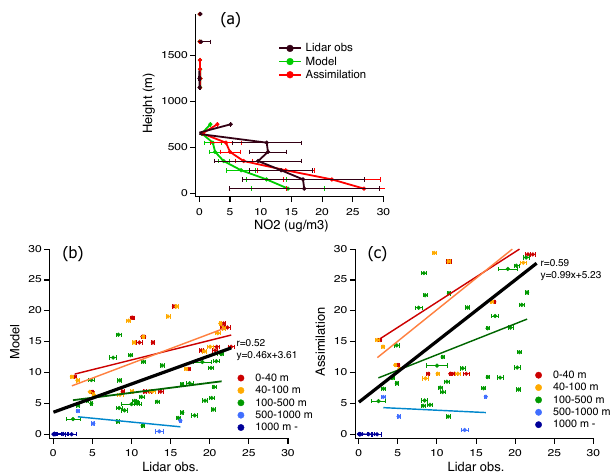
Fig. 12. (a) Mean vertical profiles of the NO 2 concentrations (µgm 3 ) obtained during the DANDELIONS campaign in Septem- ber 2006. The black lines represent the lidar observation; the green lines represent the model simulation; the red line represents the data assimilation run. The error bars represent the standard deviation of all the data within one grid. Lower panels show scatter plots of NO 2 concentrations (µgm 3 ) for (b) the model simulation and (c) the data assimilation run during the DANDELIONS campaign. The straight lines represent linear regression lines for each level. Each line rep- resents a linear fit to the points of the same colour, and the colours represent the altitude level. The black line shows a linear fit to all of the